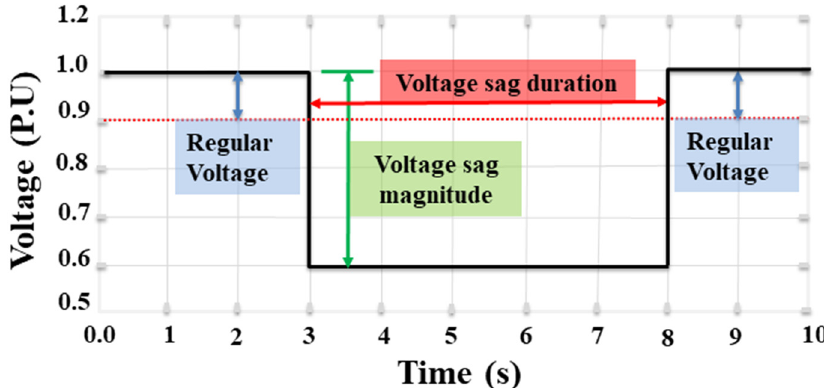
Figure 8. The voltage sag characteristics.